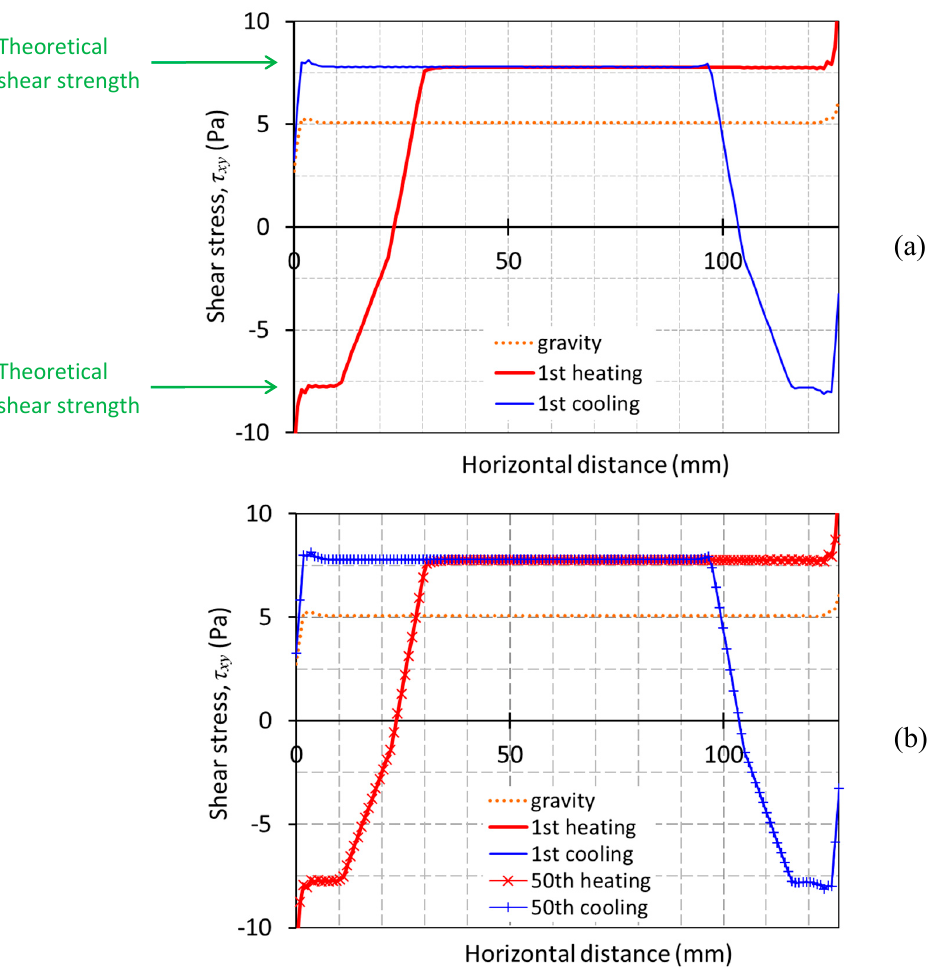
Figure 13. Distributions of interface shear stress ( τ xy ) at the acryl-wood interface. The presented results are based on ∆ T = 31 ◦ C in β = 10 ◦ slope with the parameters in Table 1. ( a ) and ( b ) are the same as in Figure